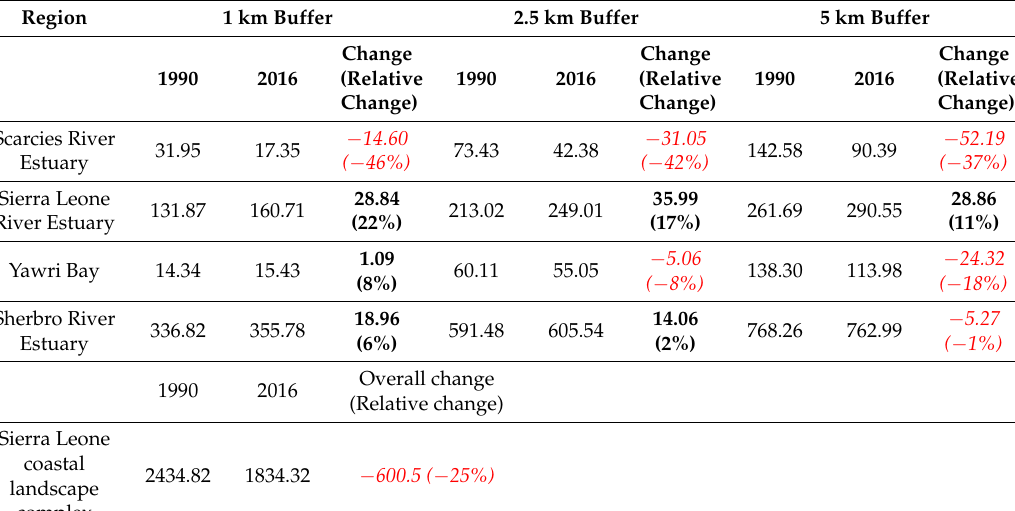
Table 5. Summary of mangrove extents (area in sq. km.) during 1990 and 2016 for the four focus areas in the Sierra Leone coastal landscape complex. Values in bold denote mangrove gain, while values in red italic denote mangrove loss during 1990–2016. The ‘Sierra Leone coastal landscape complex’ refers to all the mangroves along the full length of the coast, not only in the buffers in the four areas. Region 1 km